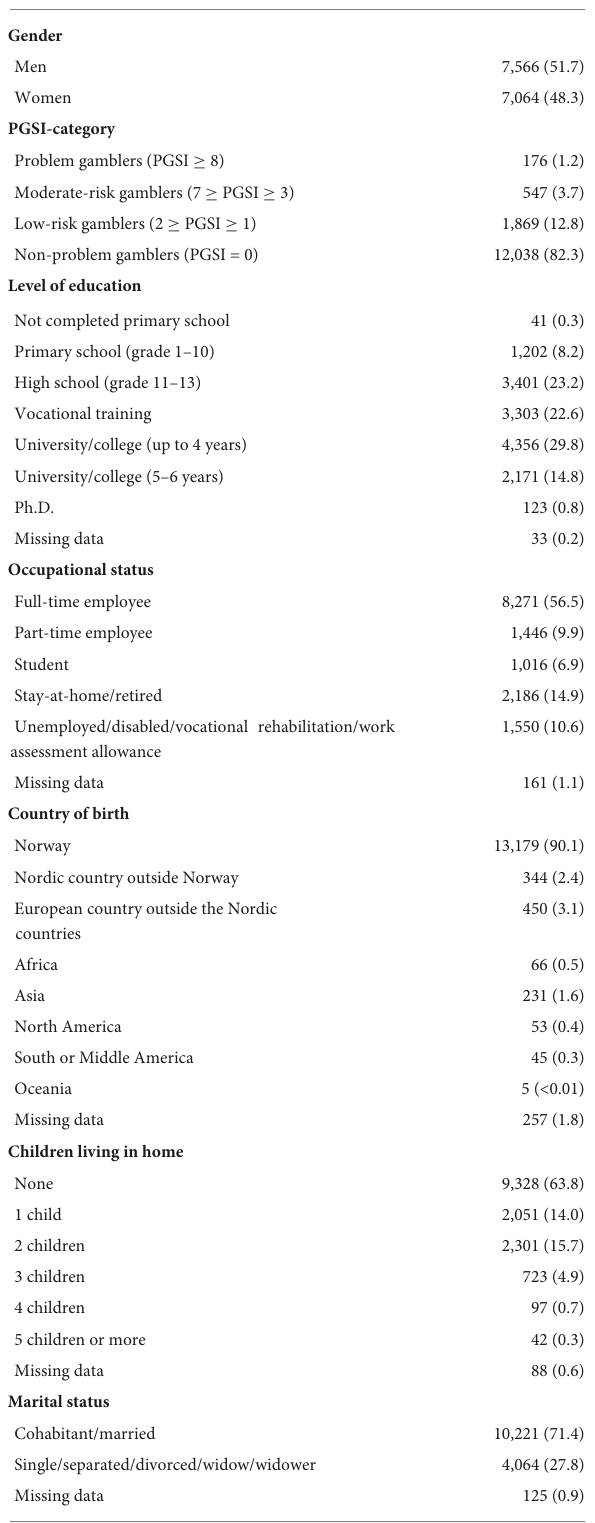
TABLE 1 Demographic characteristics of the